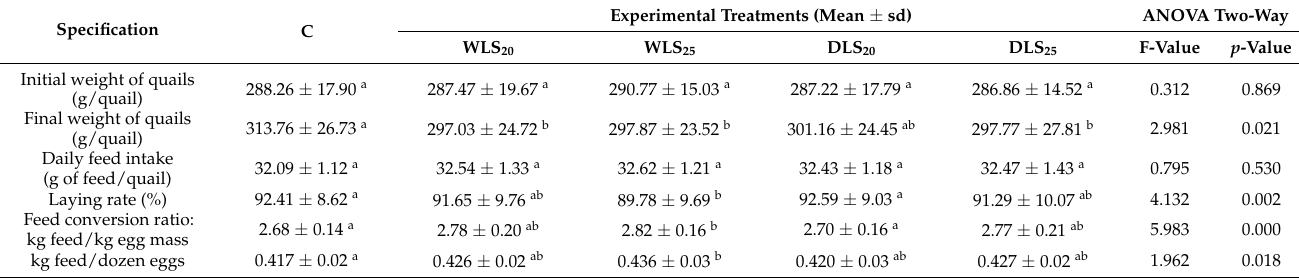
Table 5. Influence of using dehulled white lupine seeds in the laying quail diets on the performance responses.